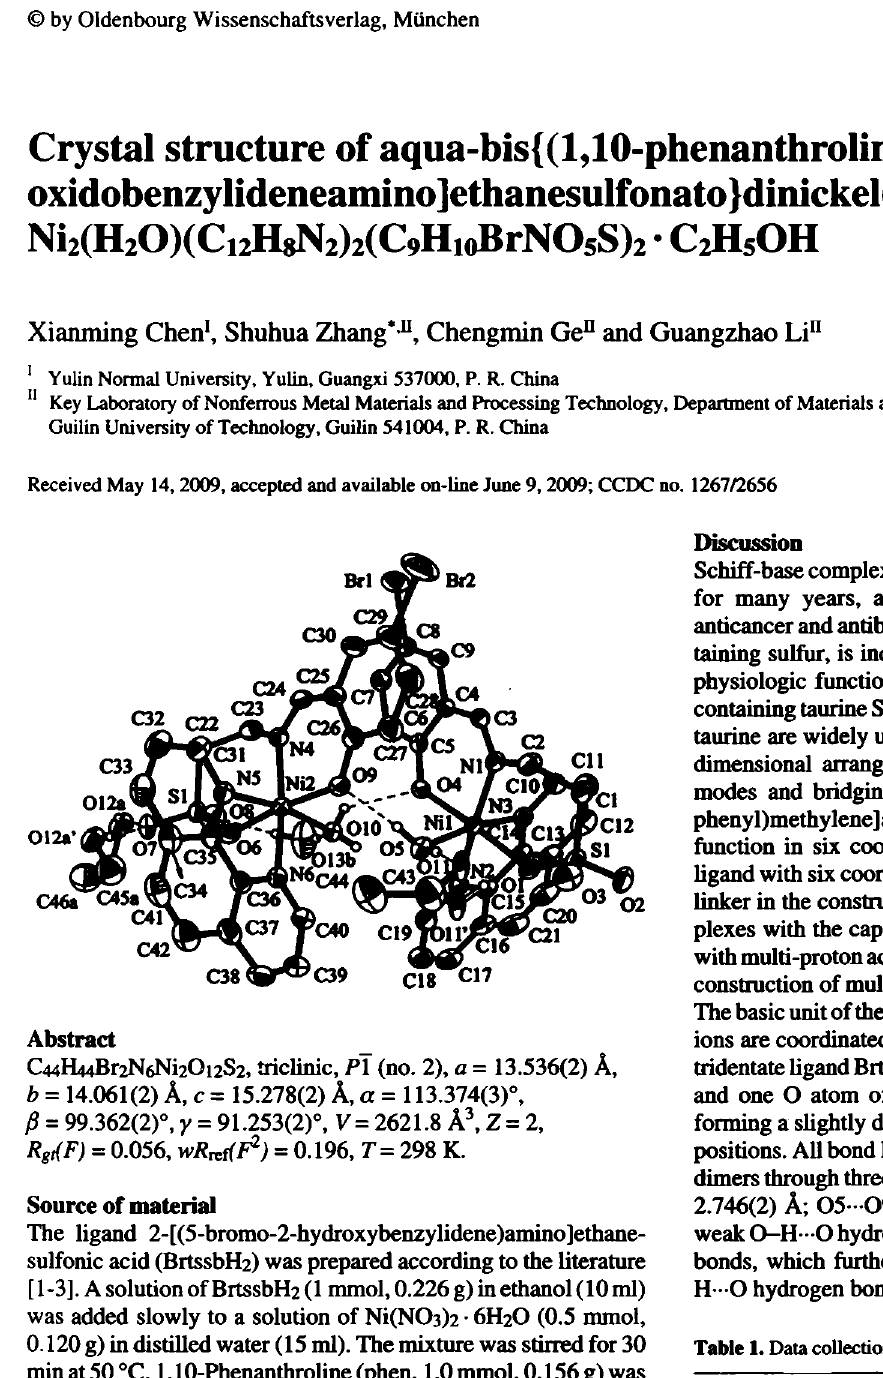
Table 1. Data collection and